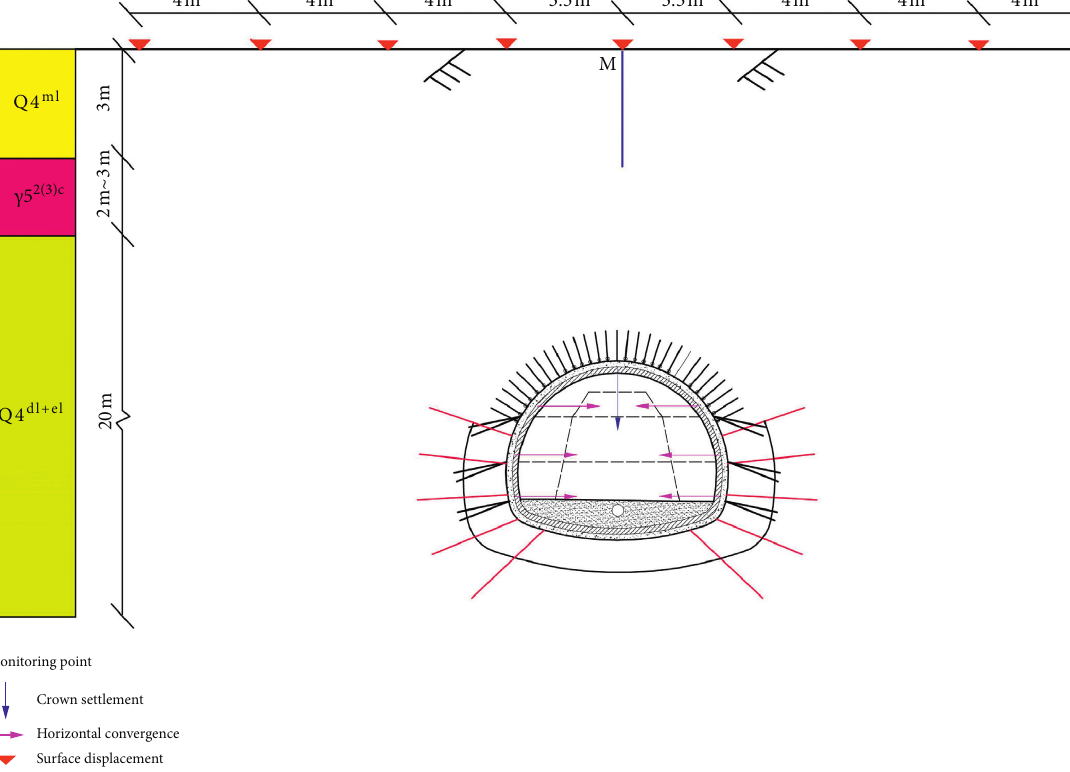
(2) The total horizontal convergence of arch shoulder is bigger than arch waist and arch feet. The maximum total crown settlement reached 82.8 mm ∼ 99.8 mm.